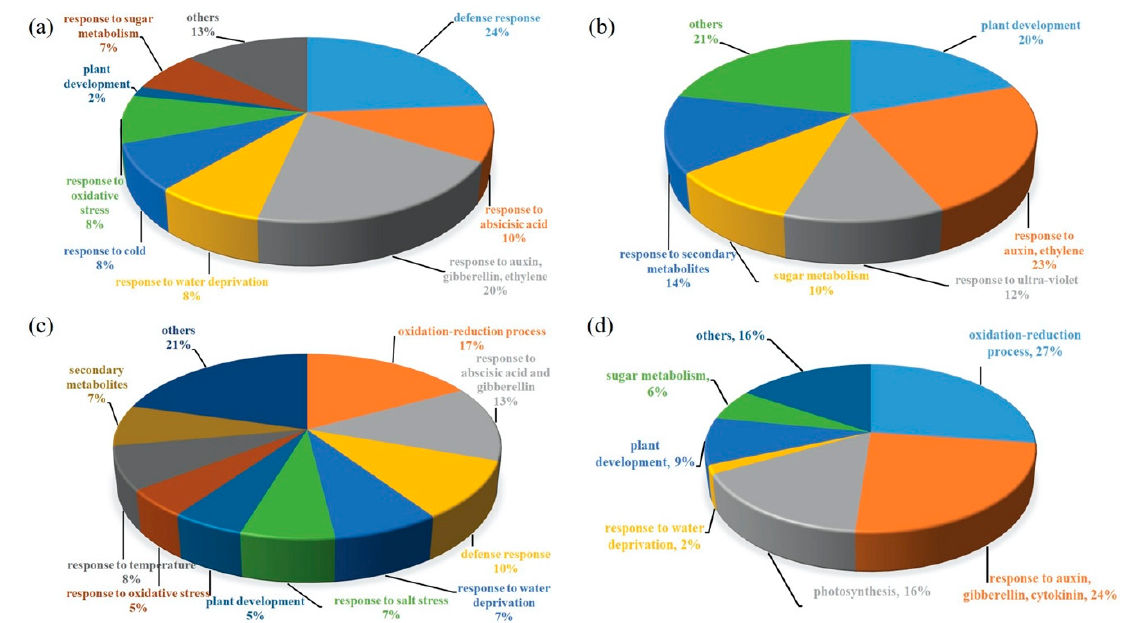
Figure 4. Functional categories grouping of genes which showed > 2-fold change in expression, in mannitol-producing line vs. wild type pairwise comparisons, in standard and salinity stress conditions. ( a ) Up-regulated at 24 and 48 h under standard conditions. ( b ) Down-regulated at 24 and 48 h under standard conditions. ( c ) Up-regulated at 24 and 48 h under salinity stress. ( d ) Down-regulated at 24 and 48 h under salinity stress. Percentages for each category represents the number of genes involved in the functions out of total number of genes that were up- and down-regulated > 2 fold at p value < 0.05 for both 24 h and 48 h time points.